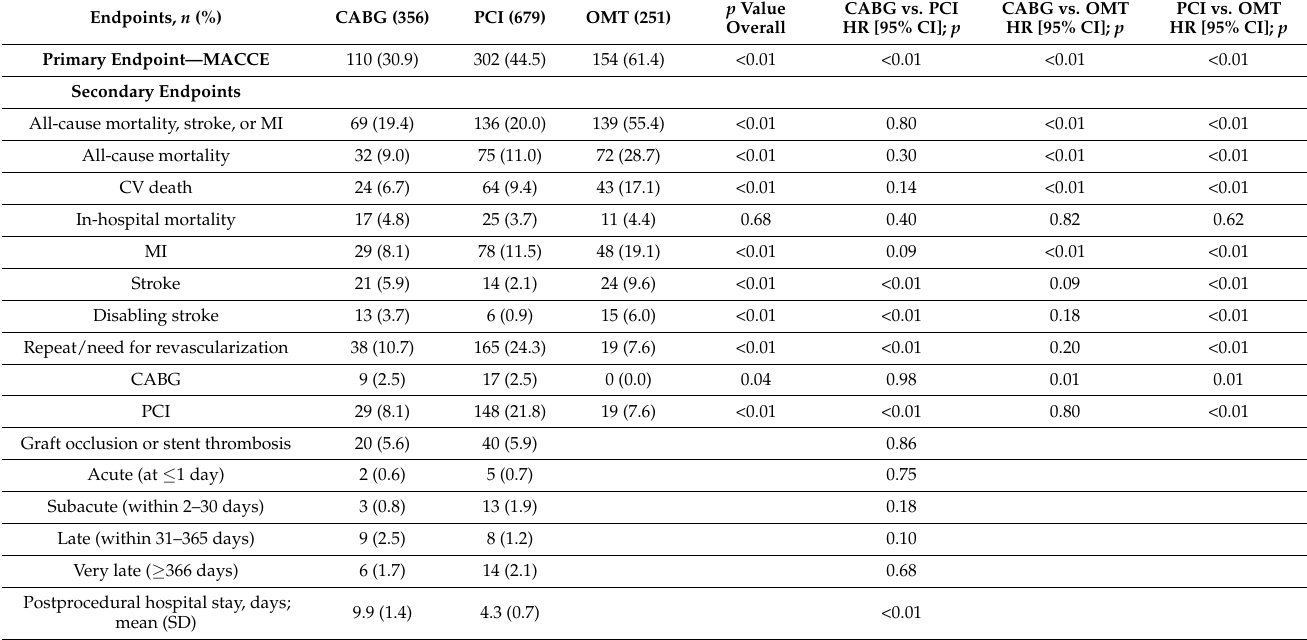
Table 3. Primary and secondary